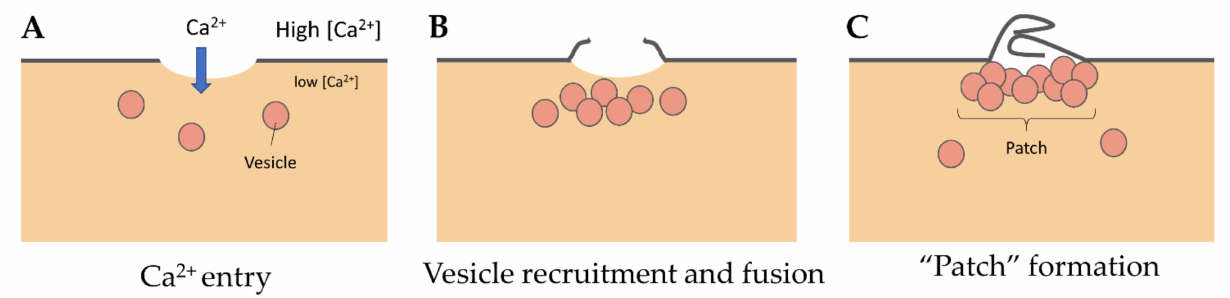
Figure 2. “Lipid patch” repair mechanism. ( A ) In the “lipid patch” model, the micrometer-sized rupture of the plasma membrane is followed by a massive entry of Ca 2+ into the damaged cell. ( B ) The local increase in intracellular Ca 2+ concentration initiates the recruitment of intracellular vesicles and ( C ) their fusion to form a vesicular aggregate or “patch”. The “patch” fuses at the ruptured area and plugs the lesion, which stops the mixing of extracellular and intracellular